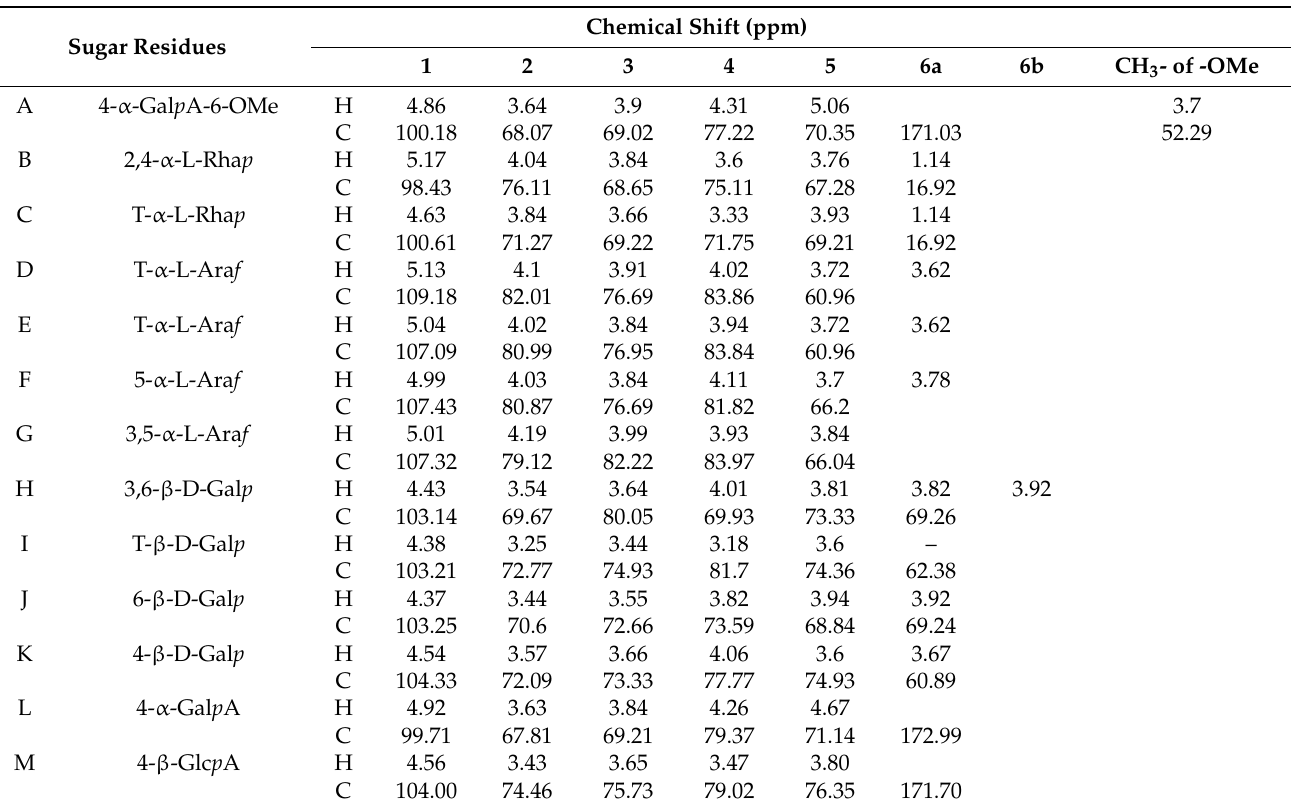
Table 2. The 1 H NMR and 13 C NMR chemical shifts for